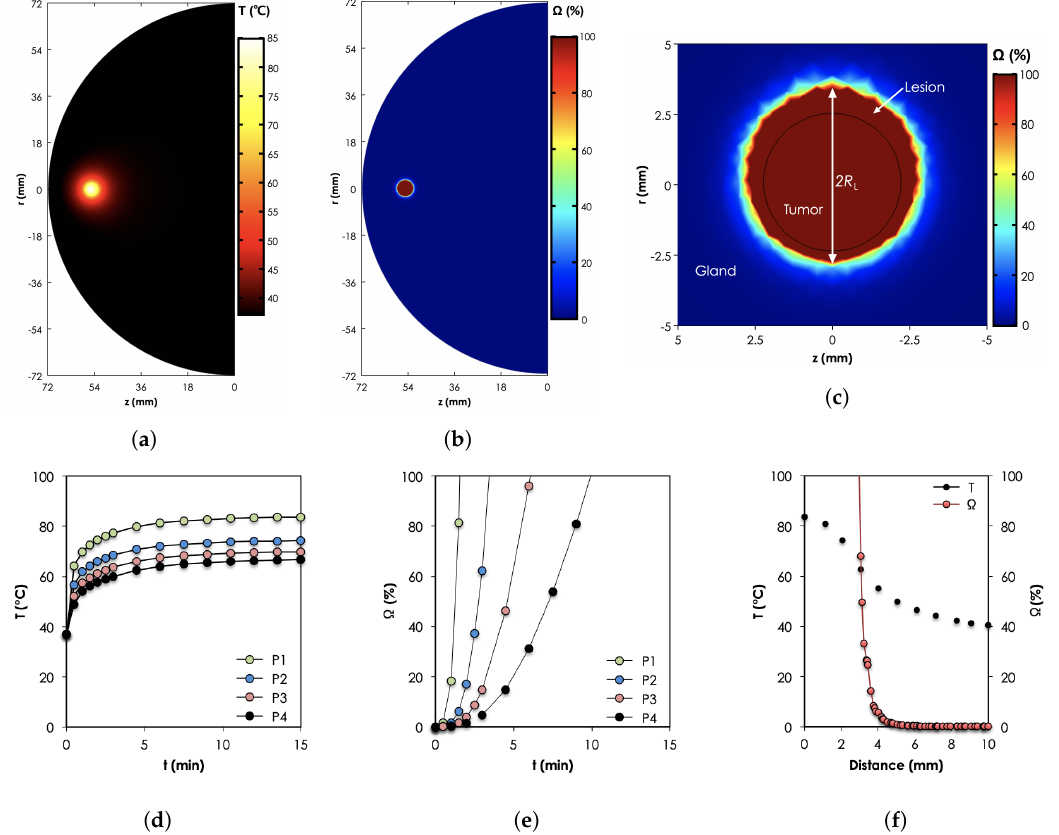
Figure 4. Simulation results. Cross-sectional view of the ( a ) temperature distribution, ( b ) thermal damage, ( c ) thermal damage showing the lesion parameter. Temporal response curves for ( d ) temperature and ( e ) thermal damage at the control points (P1–P4, cf. Figure 3). ( f ) Temperature and thermal damage as a function distance from P1. Simulation settings: P 0 = 1 W, t = 15 min and T max = 85 ◦